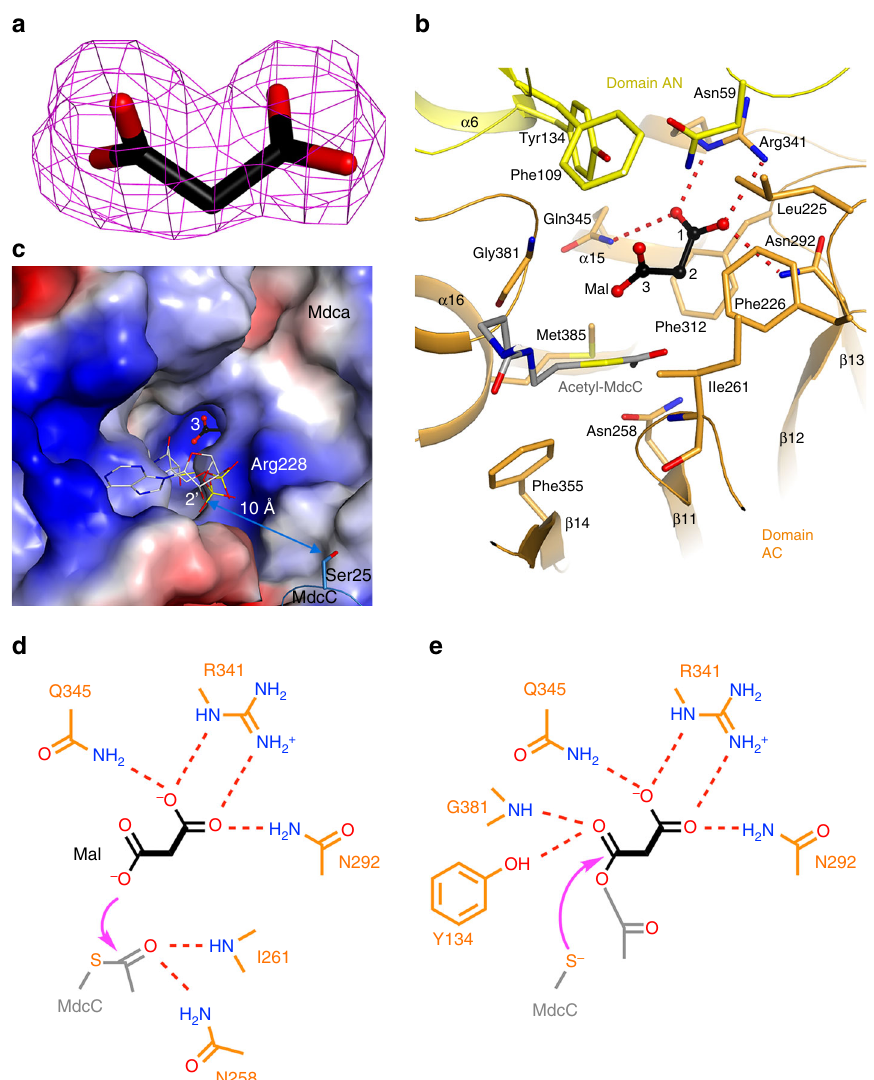
Figure 5 The active site of MdcA. a Simulated-annealing omit F o − F c electron density map at 2.2 Å resolution for malonate in the active site of MdcA, contoured at 3 σ . b Interactions between malonate ( black , labeled Mal, with its carbon atoms numbered) and the MdcA active site. Hydrogen-bonding interactions for the C1 carboxylate of malonate are indicated with dashed lines ( red ). A model for the acetylated prosthetic group of MdcC is shown in gray . c Molecular surface of the active site region of MdcA, colored by electrostatic potential ( red : negative, blue : positive). Malonate is located at the bottom of a deep, narrow pocket. A model for the acetylated prosthetic group of MdcC is shown in gray . d Schematic drawing of residues involved in the fi rst step of catalysis by MdcA. The attack of the carboxylate oxygen atom on acetyl-MdcC is indicated by the arrow ( magenta ), and possible residues stabilizing the oxyanion of the transition state are also shown. e Schematic drawing of residues involved in the second step of catalysis by MdcA. The attack of the thiolate on the anhydride intermediate is indicated by the arrow ( magenta